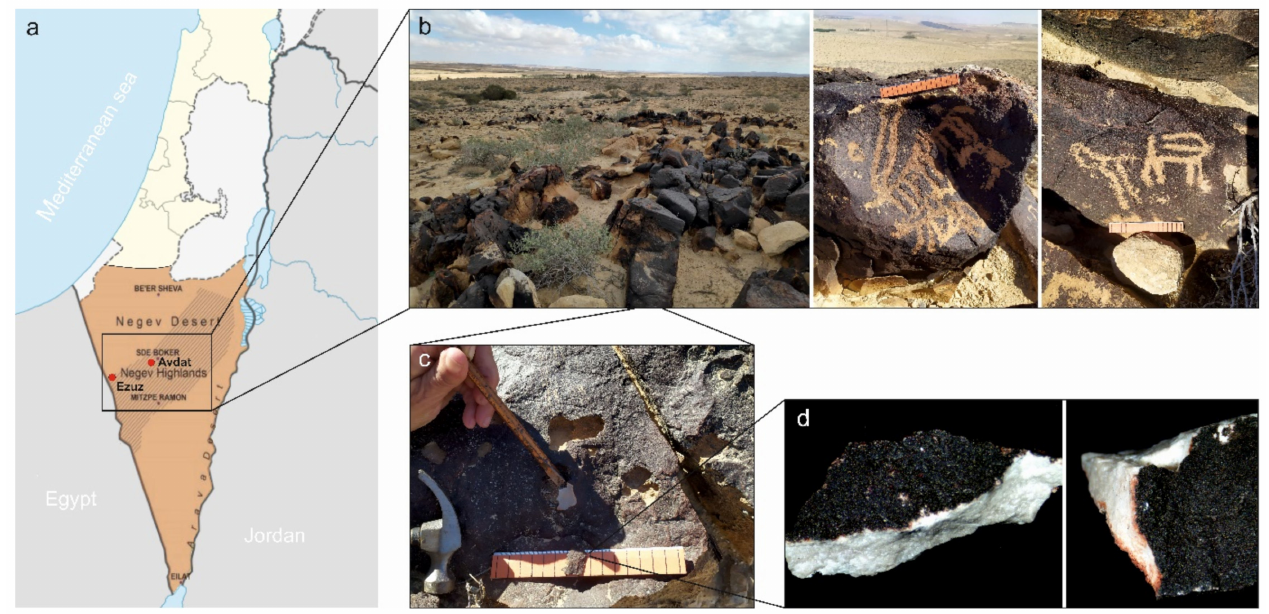
Figure 1. Map of the Negev desert indicating the location of the two petroglyph sites ( a ); view of the rock art site in Ezuz with examples of rock engravings ( b ); image of a sampling point ( c ); and the sample observed by stereomicroscope (6 × ) ( d